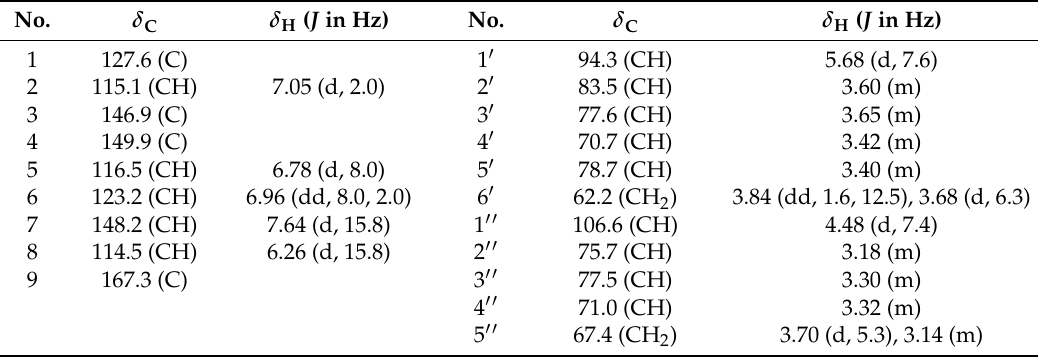
Table 1. 13 C-NMR (100 MHz) and 1 H-NMR (400 MHz) spectral data of compound 1 in MeOD.